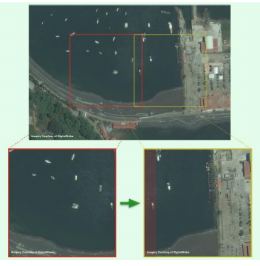
Figure 11. Large image